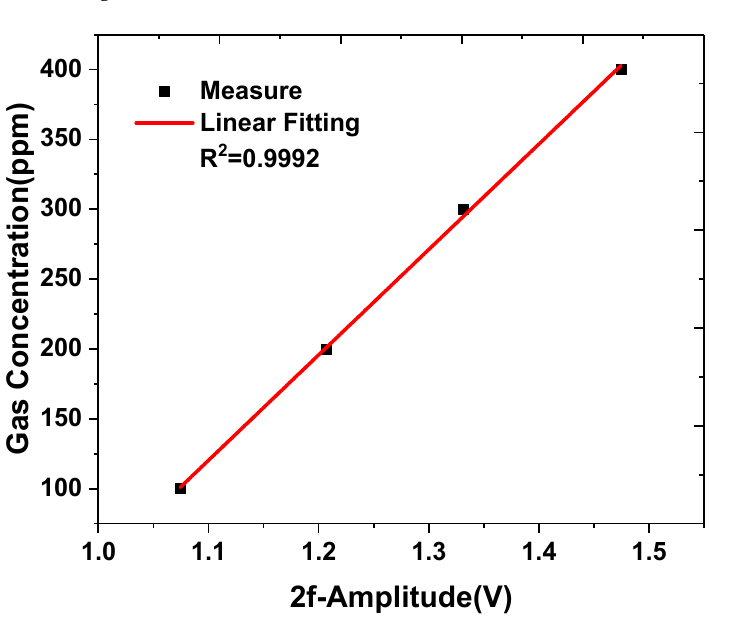
Figure 7. Fitting relationship between 2f signal amplitude and concentration obtained from sample